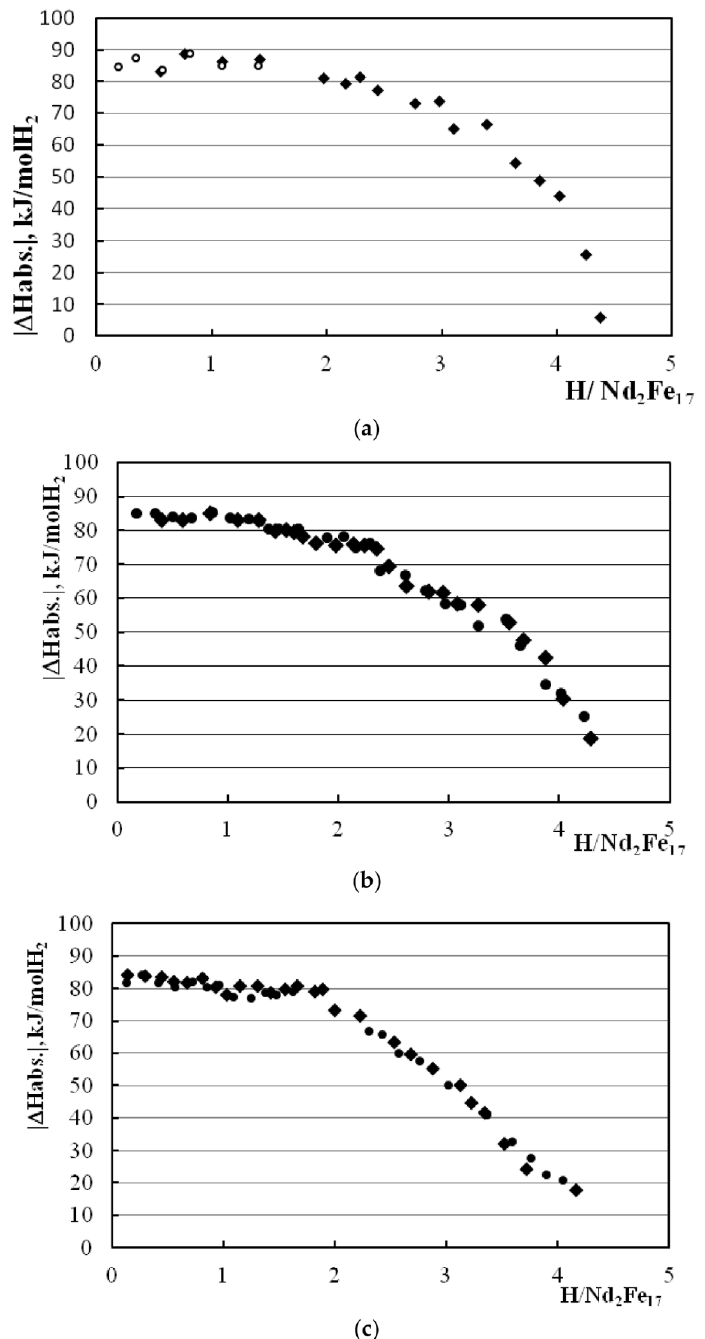
Figure 3. ( a ) Absorption enthalpy vs. composition at 200 ◦ C for the Nd 2 Fe 17 -H 2 system. The different symbols refer to different runs of determination [8]; and ( b ) Absorption enthalpy vs. composition at 250 ◦ C for the Nd 2 Fe 17 -H 2 system. The different symbols refer to different runs of determination. ( c ) Absorption enthalpy vs. composition at 300 ◦ C for the Nd 2 Fe 17 -H 2 system. The different symbols refer to different runs of